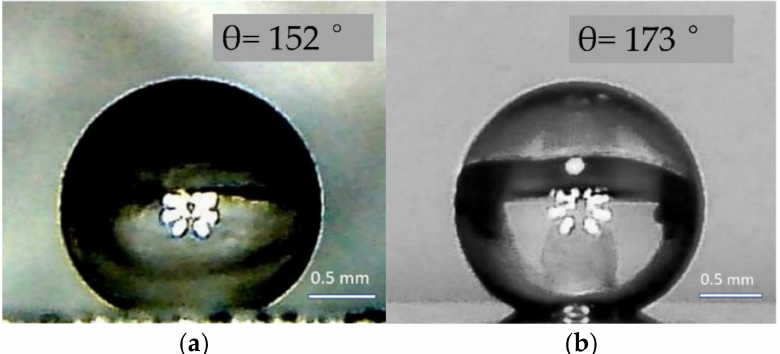
Figure 5. The shape of water droplets and the magnitude of contact angles on the surfaces of pure type II ZnO ( a ) and with a coating of Fe 2 O 3 ( b ).